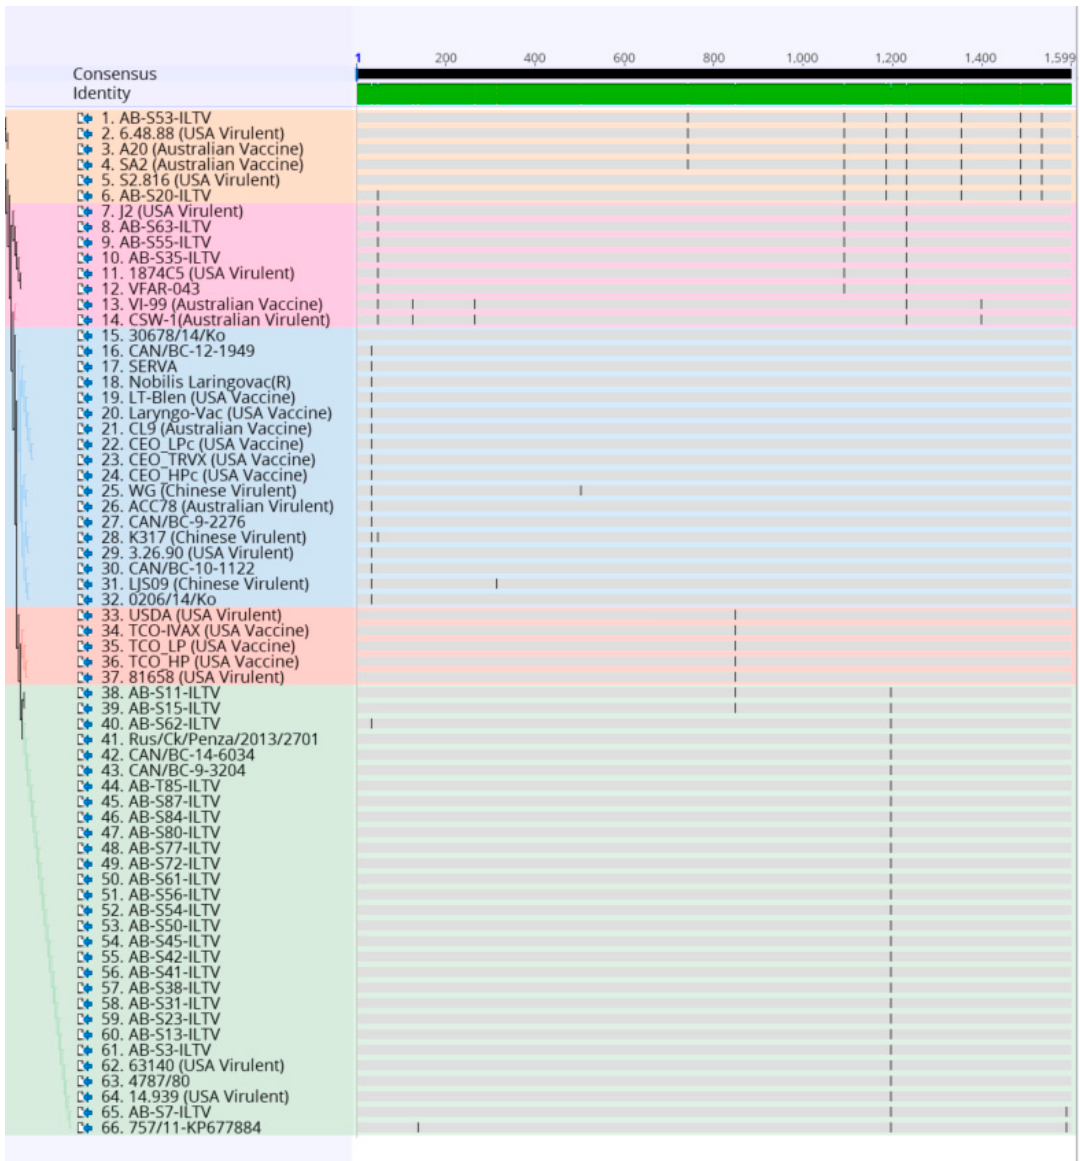
Figure 2. Alignment of the nucleotide sequences of 32 Canadian ILTV strains and 34 ILTV reference strains using MUltiple Sequence Comparison by Log-Expectation (MUSCLE) and Geneious software package. Vertical lines indicate single nucleotide polymorphism (SNP) positions. Samples are color-coded as the phylogenetic tree.